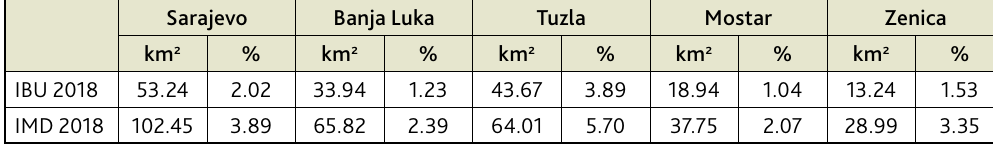
Table 4. Detailed Imperviousness densityof FUAsshown by percentages FUAs